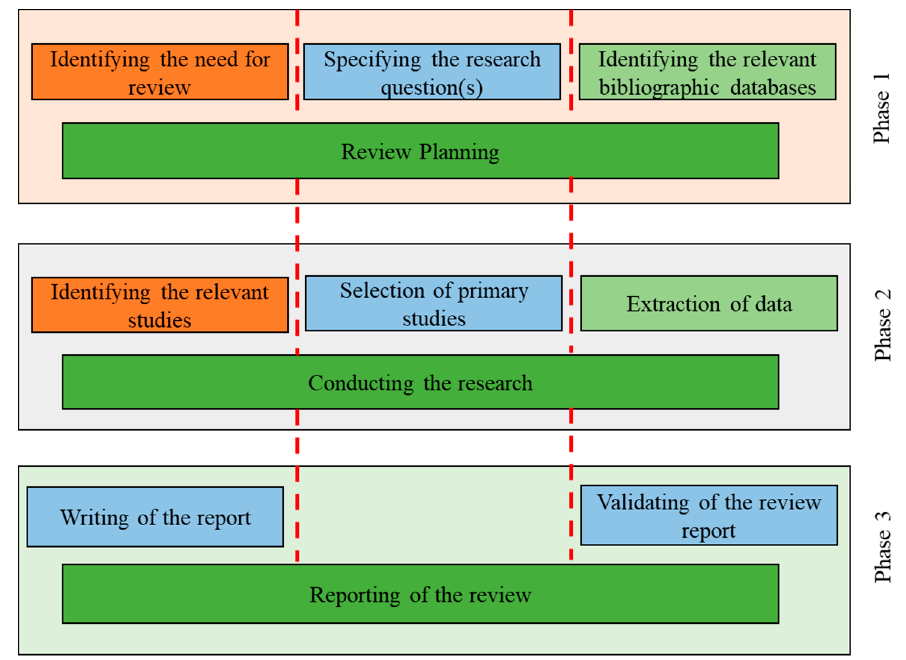
Figure 2. SLR phases and activities.